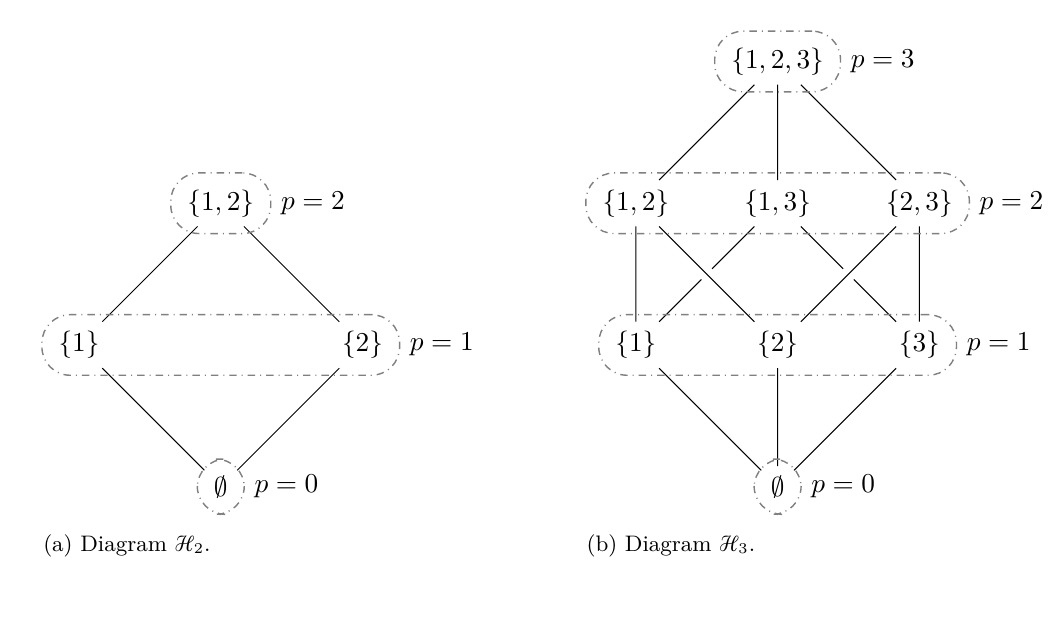
Figure 2. Hasse diagram H n for the poset ( P ( A n ) , ⊆ ) with n = 2 (a) and n = 3